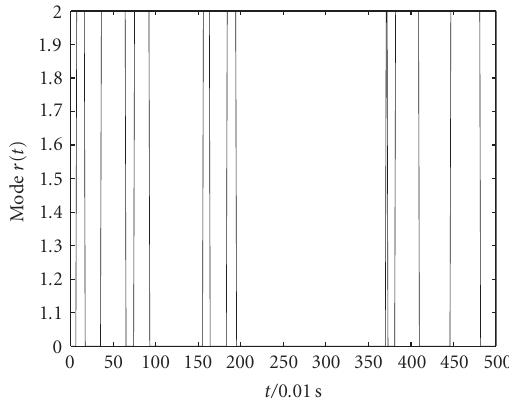
Figure 4.4. Regime transition in periodic-signal tracking.